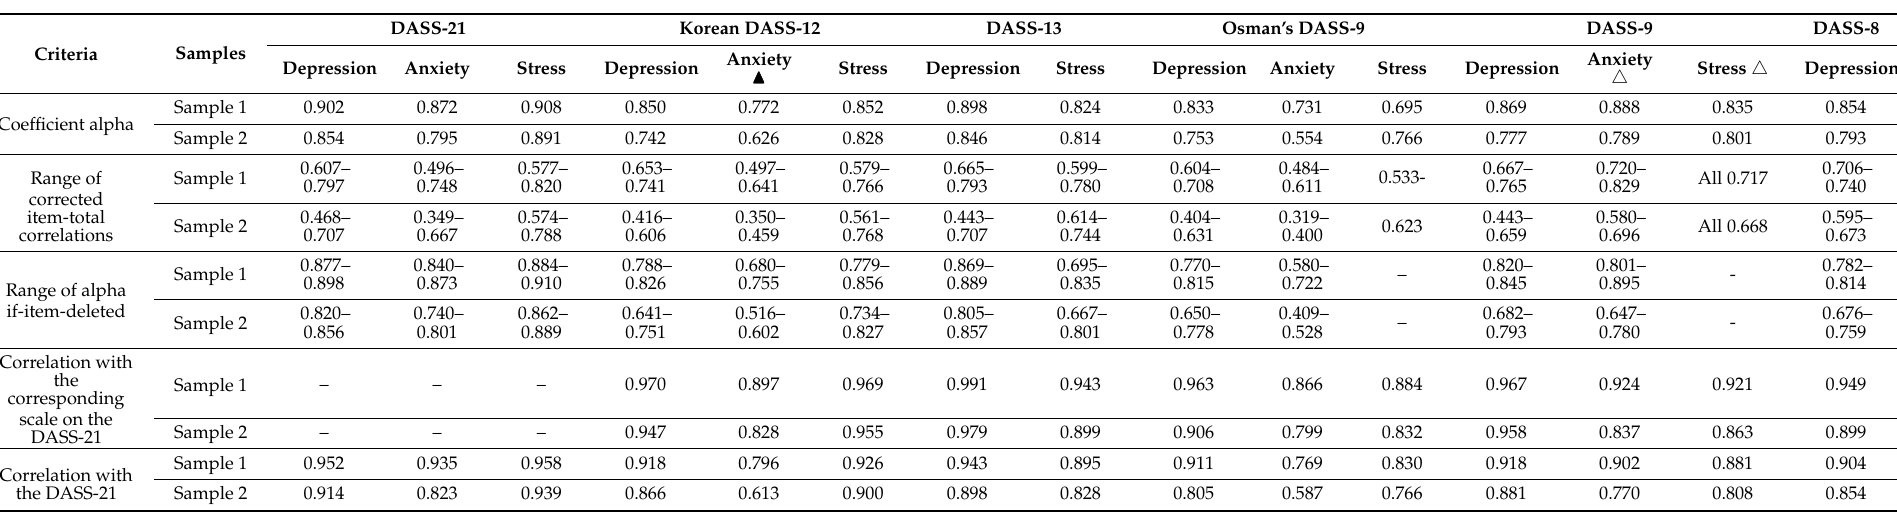
Table 5. Internal consistency of subscales of the Depression Anxiety Stress Scale 21 and shortened versions in the samples.